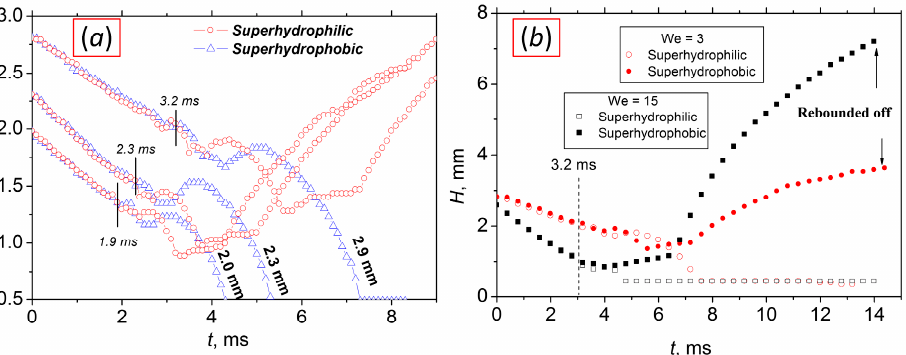
Figure 4. ( a ) Evolutions of height of droplets with different diameters impacted on superhydropho- bic and superhydrophilic surfaces We = 3. ( b ) Evolutions of height of droplets for We = 3 and 15 D 0 = 2.9 mm.